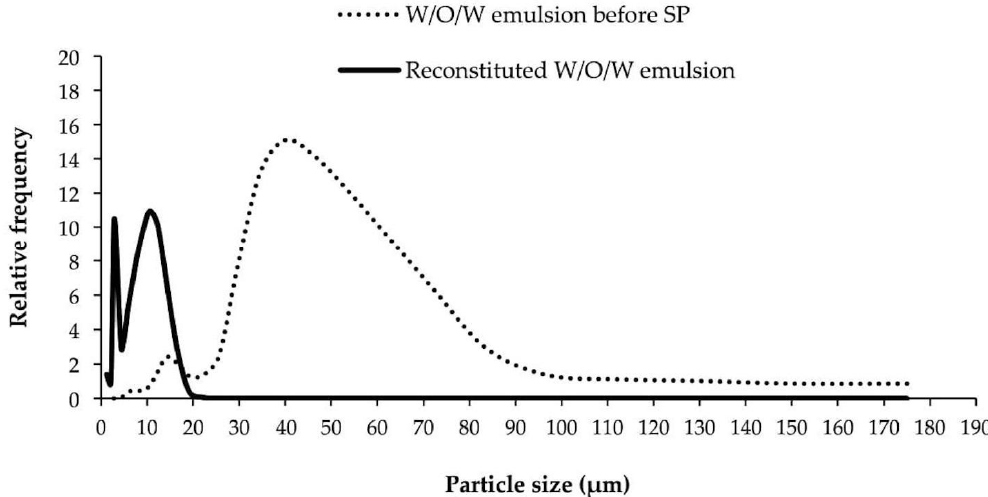
Figure 3. Particle size distribution of W/O/W emulsion before SP and reconstituted W/O/W emulsion. Drying conditions for W/O/W emulsion: 160–80 °C.